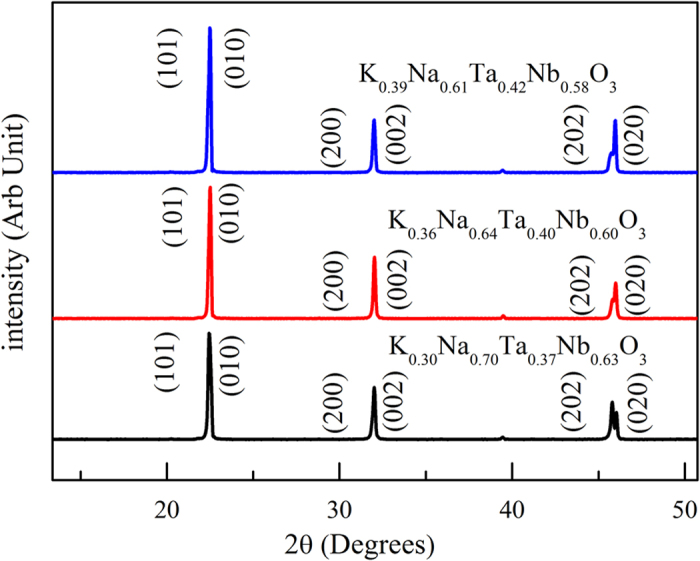
X-ray powder diffraction patterns of the as-grown K1−xNaxTa1−yNbyO3 crystals.